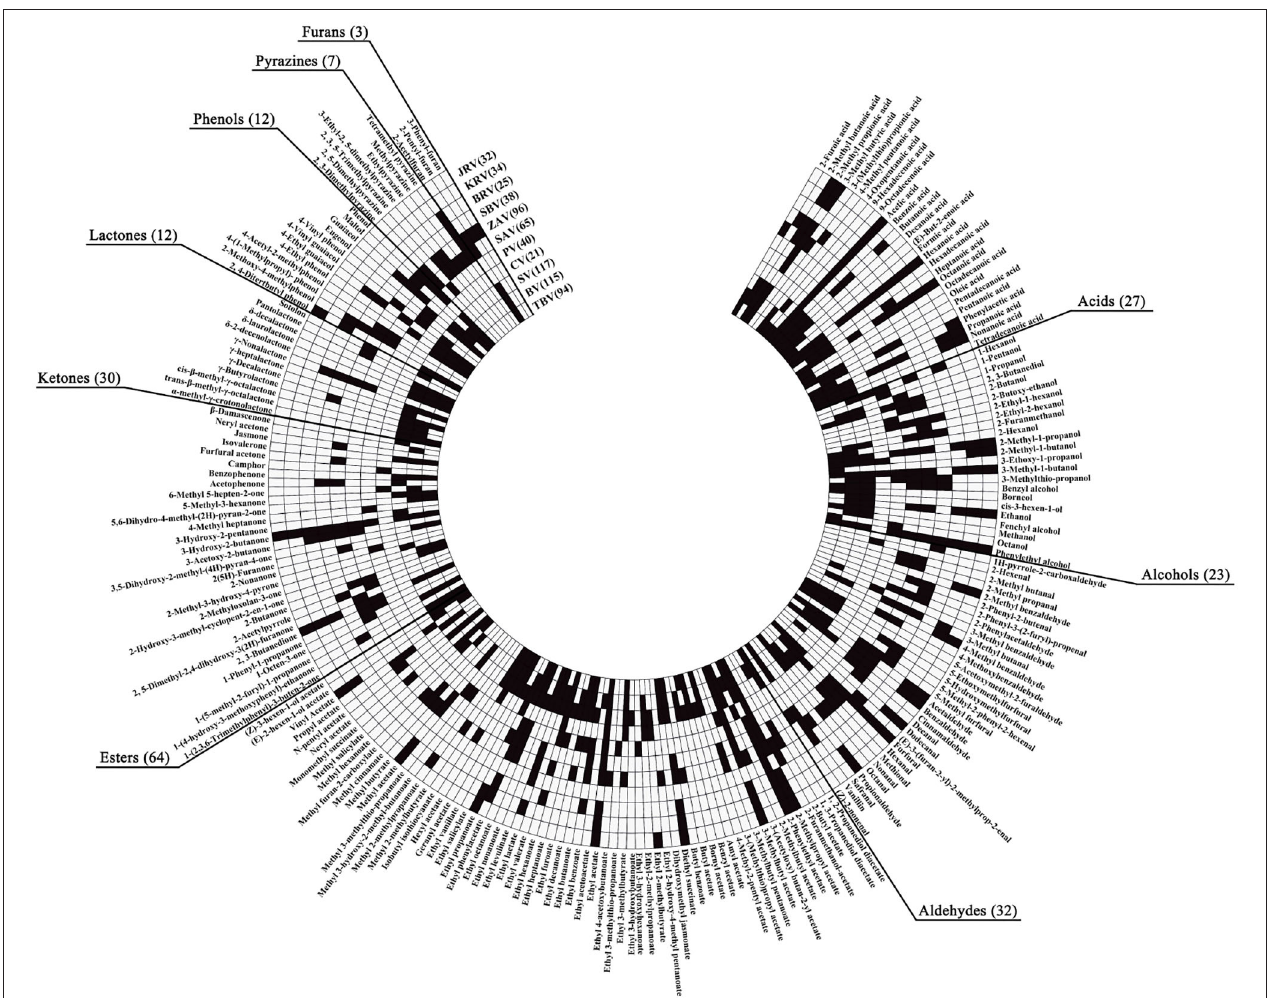
FIGURE 3 | Profiles of the VOCs from different kinds of vinegar. The small black squares indicate that the VVOCs have been detected and reported in the corresponding kinds of vinegar, and the small white squares indicate that the VVOCs have not been determined and reported in the corresponding kinds of vinegar. BV, Balsamic vinegar; BRV, Beijing rice vinegar; CV, Cider vinegar; JRV, Japanese rice vinegar; KRV, Korean brown rice vinegar; PV, Pineapple vinegar; SAV, Shanxi aged vinegar; SBV, Sichuan bran vinegar; SV, Sherry vinegar; TBV, Traditional balsamic vinegar; ZAV, Zhenjiang aromatic vinegar.